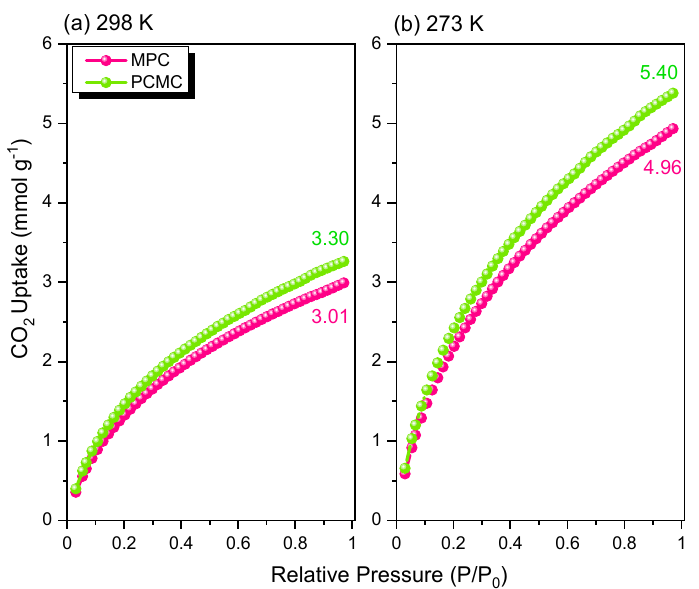
Figure 8. CO 2 adsorption profiles of MPC and PCMC, recorded at ( a ) 298 and ( b ) 273 K.